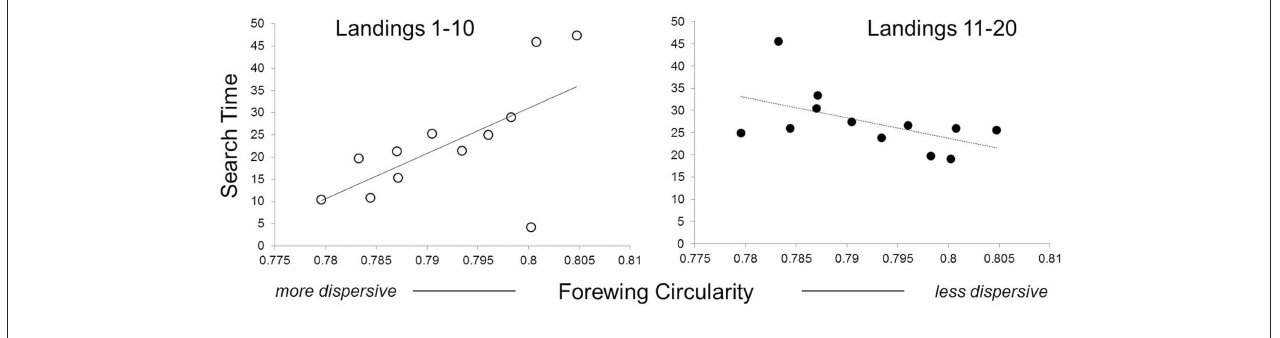
landings (in seconds) for a given butterfly family. The left panel shows behavior of naïve individuals (first 10 host-searching landings) while the right panel shows behavior of experienced individuals (second 10 host-searching landings).